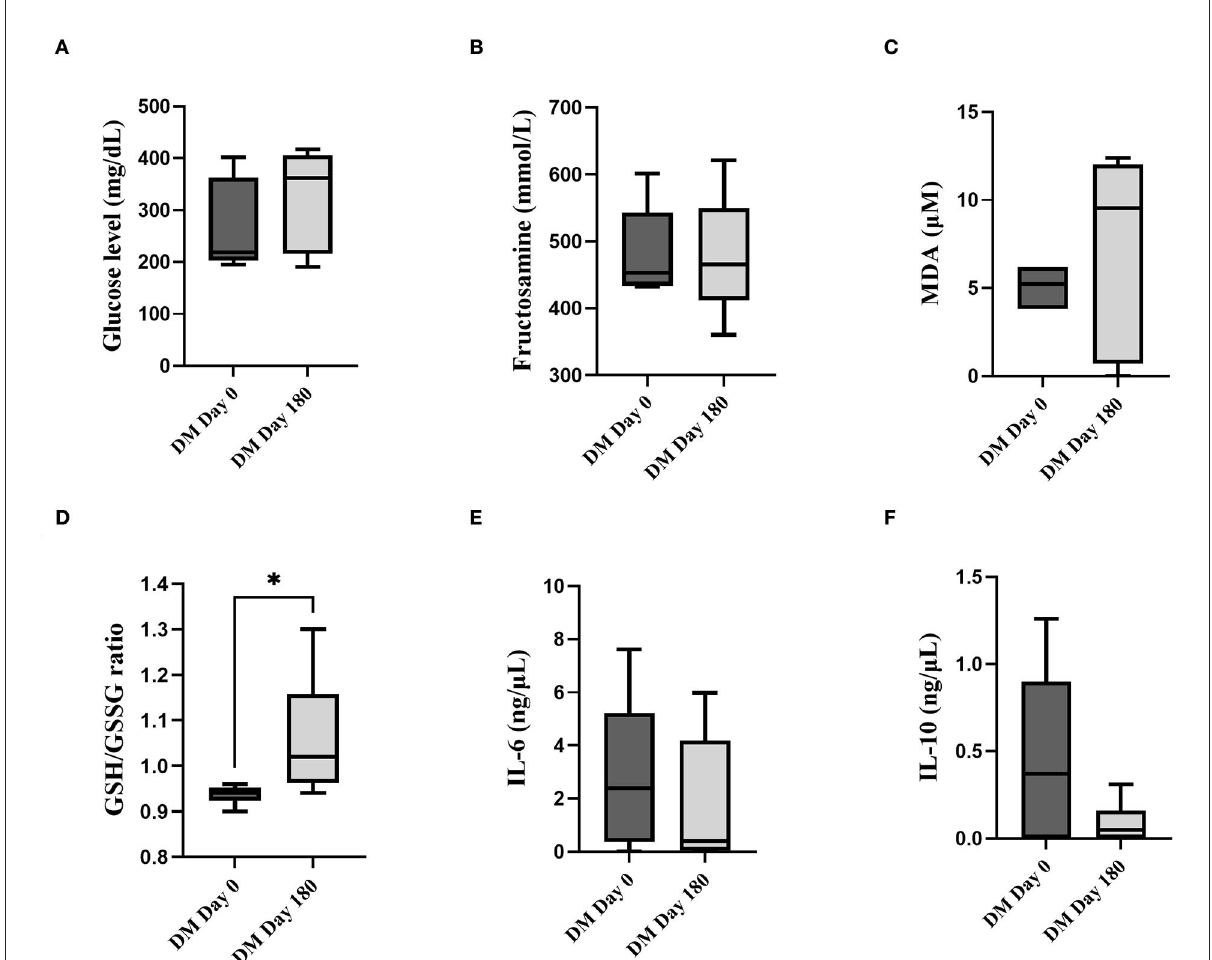
FIGURE1 Comparison between the DM day 0 and 180 groups. (A) Fasting blood glucose (mg/dL). (B) Fructosamine (mmol/L). (C) MDA ( µ M). (D) GSH/GSSG. (E) IL-6 (ng/ µ L). (F) IL-10 (ng/ µ L) (*statistically significant at P < 0.05).